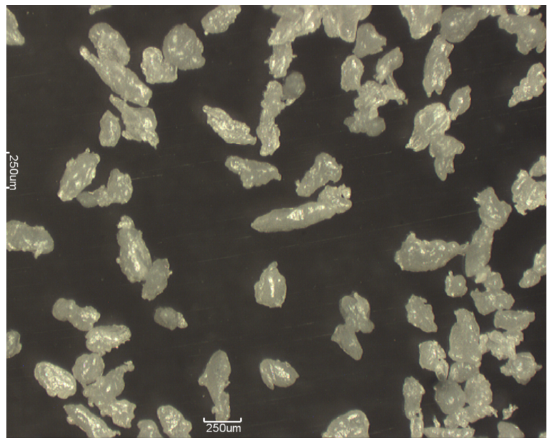
Figure 4. The shapes of particles of a representative sample of polyethylene (LDPE) powder.